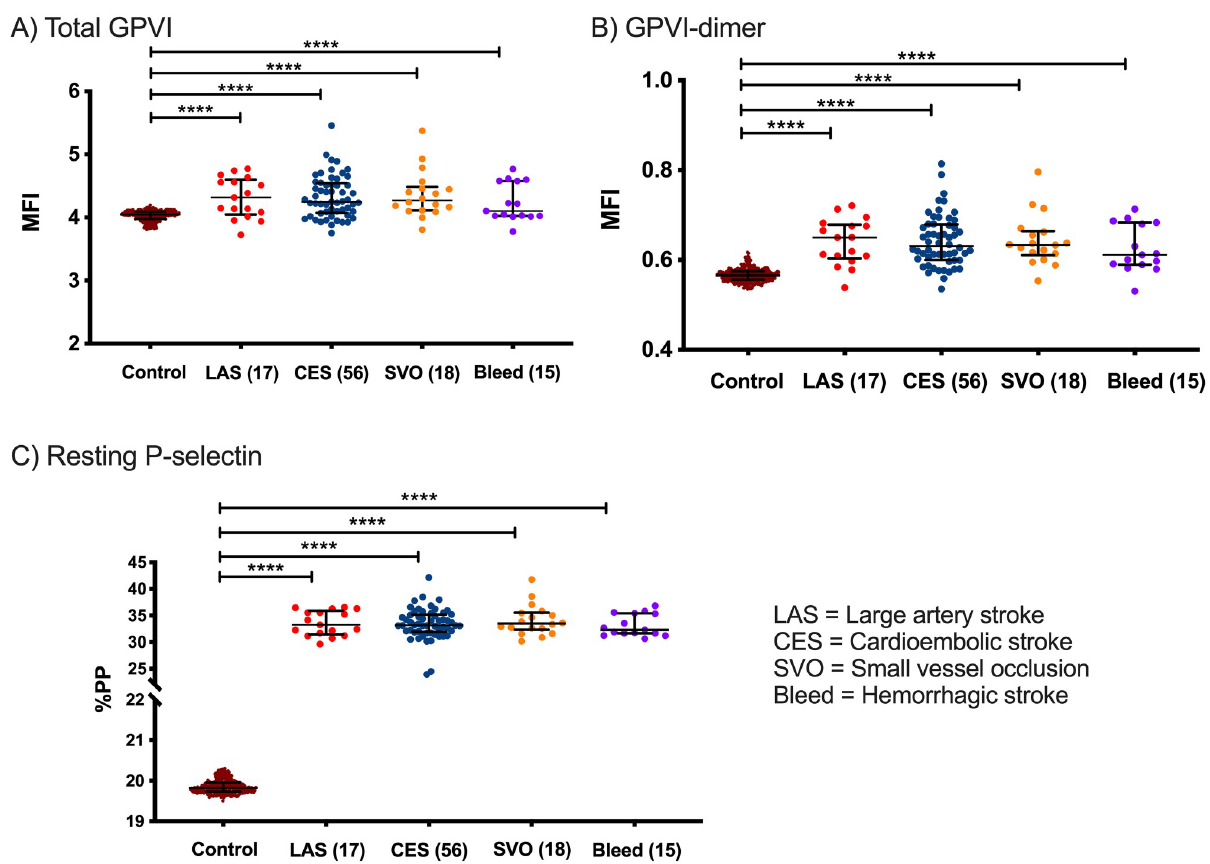
Fig 4. GPVI expression between control and stroke subtypes. A) Total GPVI expression ( P < 0.0001) and B) GPVI-dimer expression are higher in all ischemic stroke etiologies as well as hemorrhagic strokes ( P < 0.0001). P -values were calculated using one-way ANOVA with Dunnett’s multiple comparisons testing and the error bars represent the mean MFI of each of the cohorts ± SD. C) Resting P-selectin expression is higher in ischemic and hemorrhagic stroke ( P < 0.0001). P -values were calculated by a Kruskal-Wallis test with Dunn’s multiple comparisons testing for non-parametric data and the error bars represent the median (Q1–Q3) %PP of each of the cohorts. Numbers in parentheses show the number of participants within each group. MFI = mean fluorescent intensity, %PP = percentage of platelets positive.